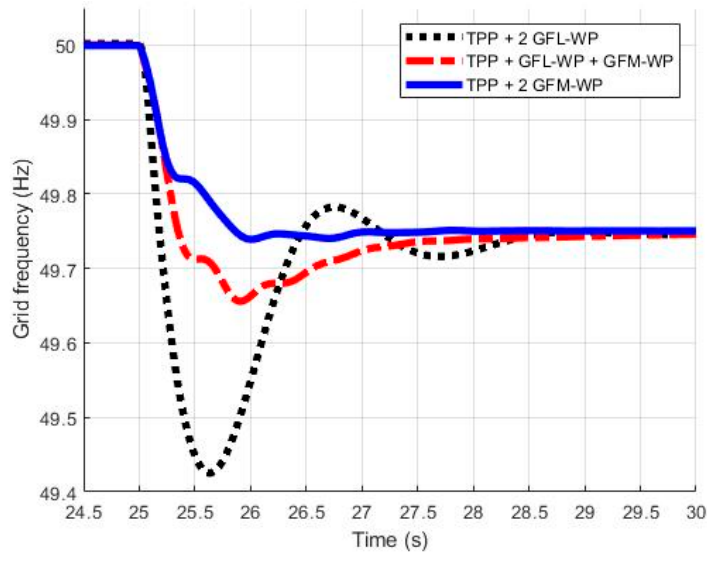
Figure 8. Comparison of GFL-FCM and GFM-FCM on FFR (system frequency). The improvements—both for the frequency nadir and for the RoCoF—are very clear,